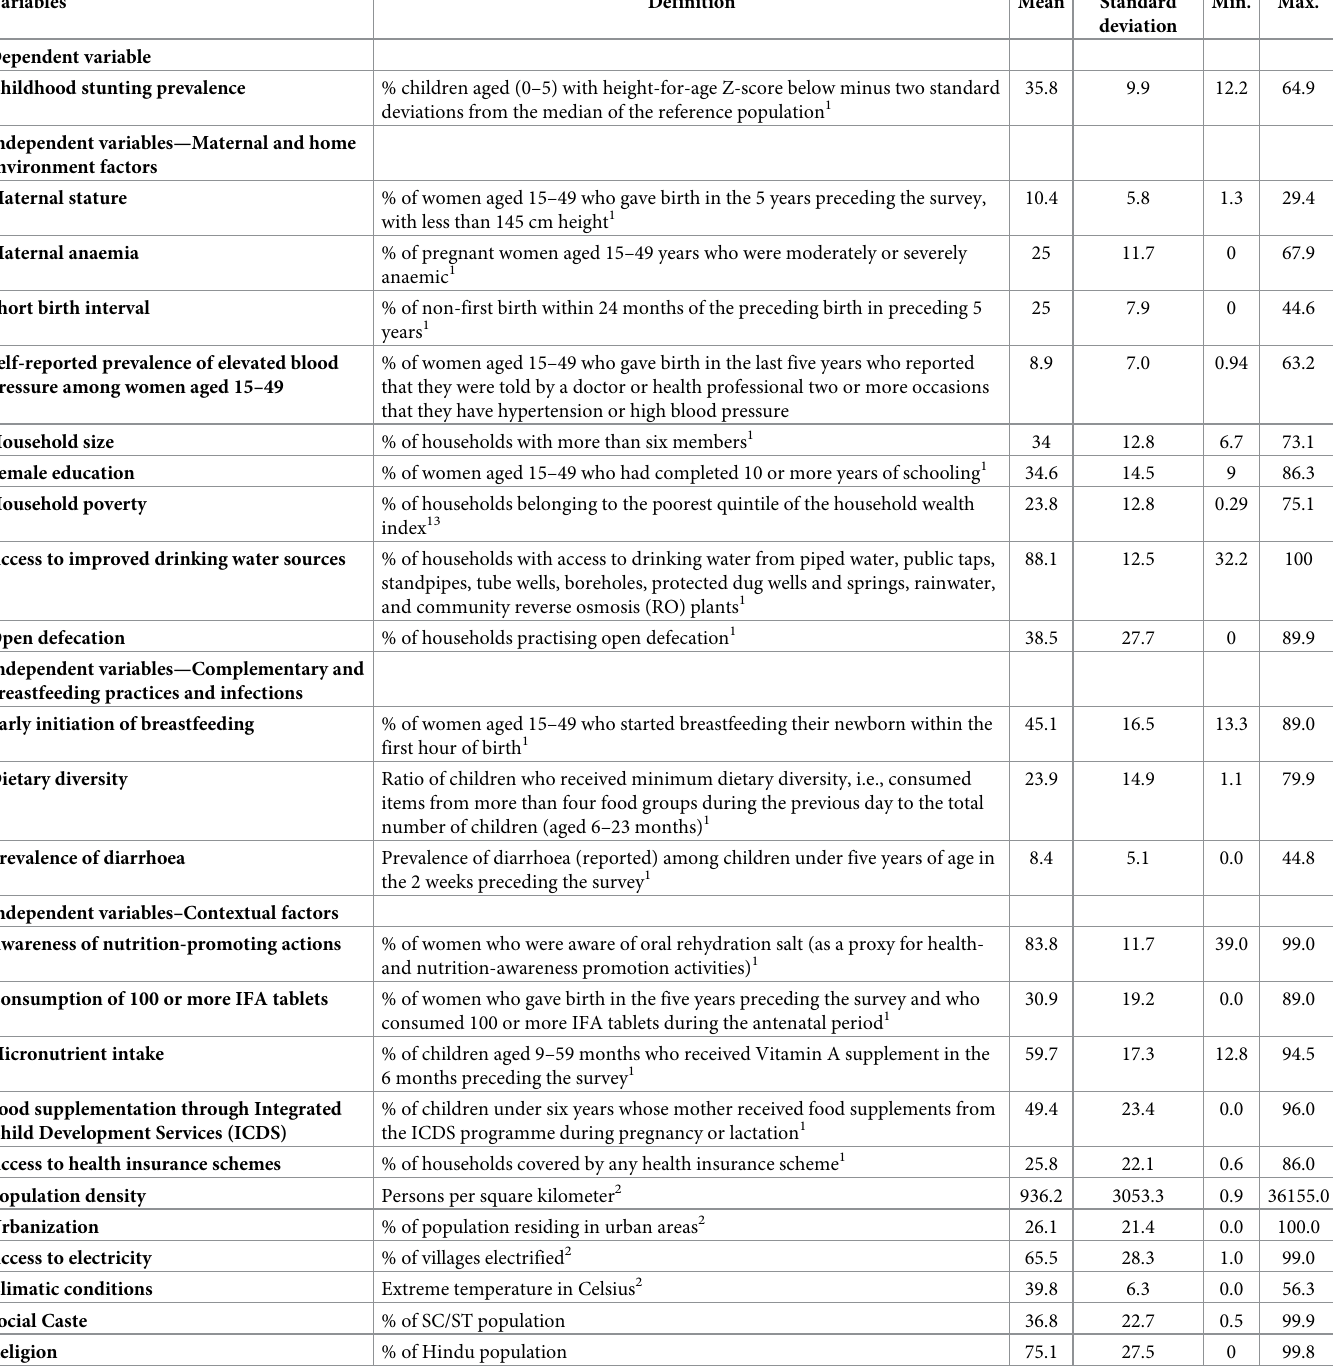
Table 1. Description and district-level summary statistics of outcome and explanatory variables used in the